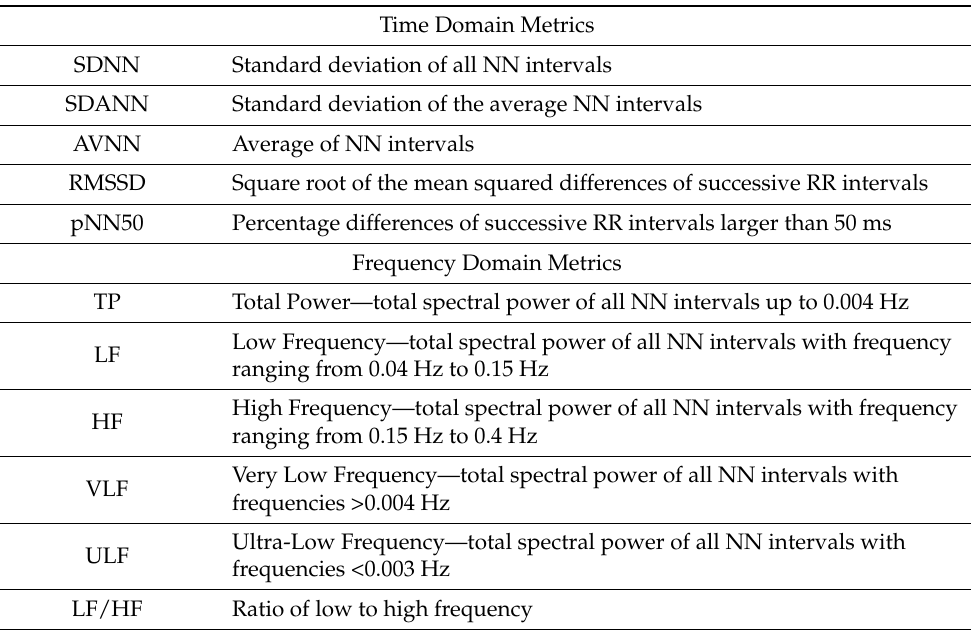
Table 1. Time and Frequency Metrics derived from Heart Rate